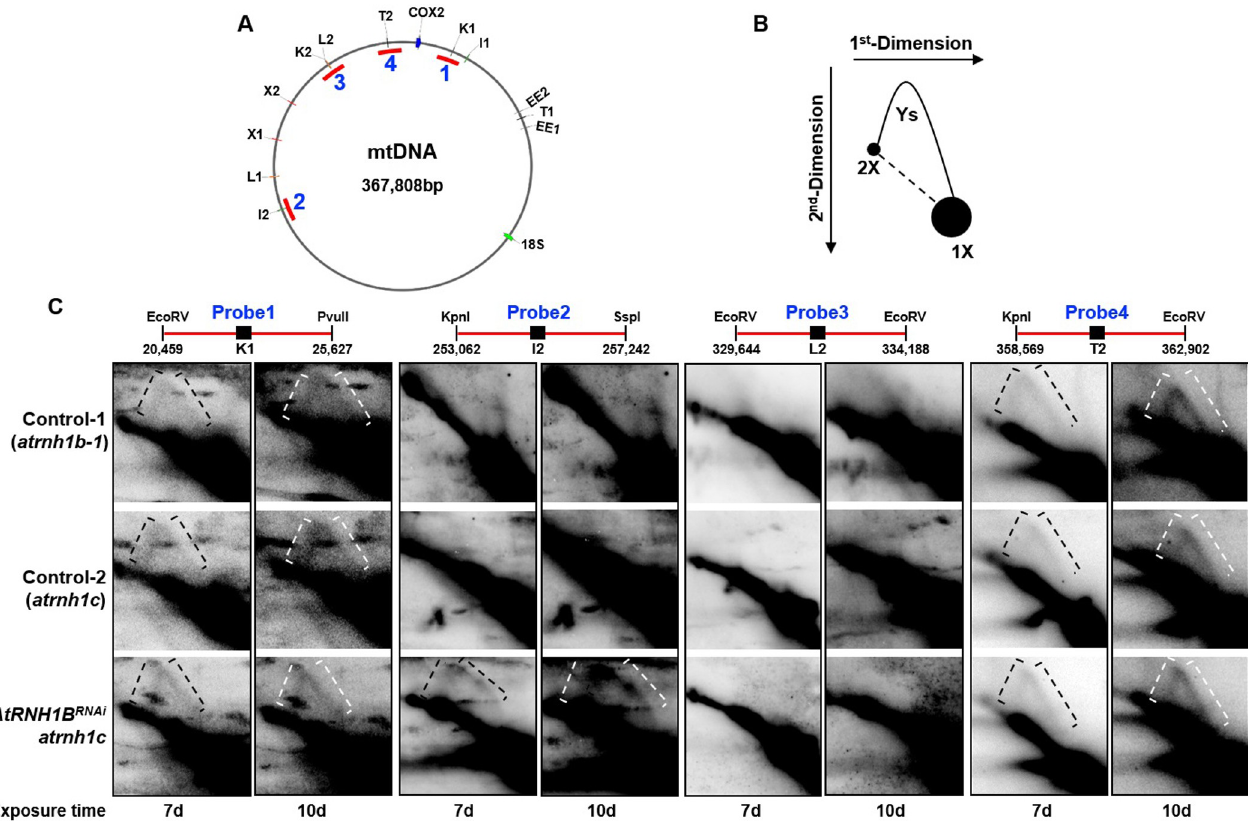
Fig 8. Two-dimensional gel analysis detects replication events in the repeats. (A) Schematic map of Arabidopsis mtDNA showing 6 repeat pairs. The fragments digested for 2D-AGE are indicated by red lines. (B) Illustration of the major 2D gel signals detected by the probe. (C) Two-dimensional gel analysis of digested mtDNA. Replication intermediates are indicated by square brackets. Probe (20,459–25,627) detects fragments containing repeat K1; Probe (253,814–256,094) detects fragments containing repeat I2; Probe (329,644–334,188) detects fragments containing repeat L2; and Probe (360,020–361,986) detects fragments containing repeat T2. The data underlying this figure can be found in S1 Raw Images. 2D-AGE, two-dimensional agarose gel electrophoresis; mtDNA, mitochondrial DNA; RNAi, RNA interference.